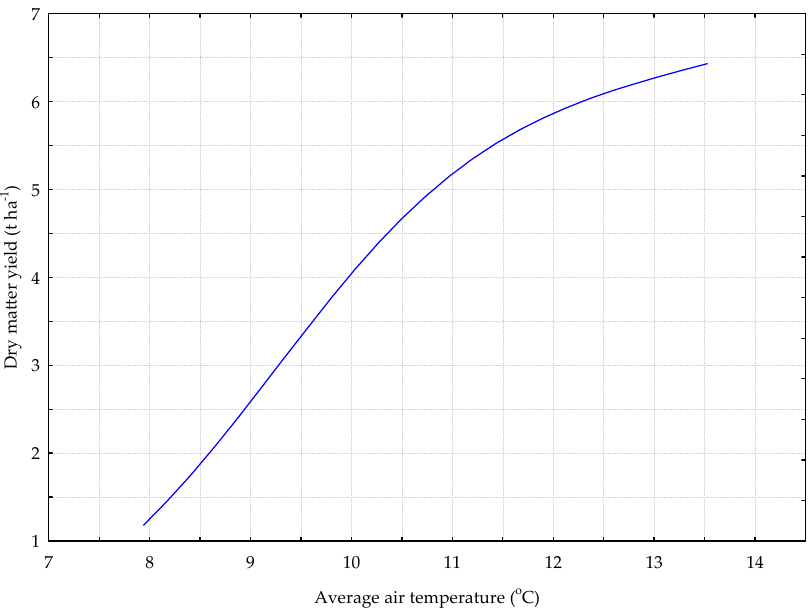
Figure 7. The Y_GB model. The response chart for variables T_AV (rank 1) and Y_DM. The dependence between the percentage of digestibility of the dry matter from the sward with the predominance of grasses and bird’s foot trefoil and the two variables with the greatest influence on explaining the variability of this trait (DIG_GB model) is presented on Figure 8. An increase in the average daily air temperature caused a decrease in the dry matter digestibility. Figure 9 shows the relation between the yield of protein from the sward with the predominance of grasses and bird’s foot trefoil and the total rainfall in the test period (PREC_S). As seen from the data, the higher the rainfall in the period ranging from the spring onset of vegetation to the harvest date was, the higher the yield of protein from the harvested biomass